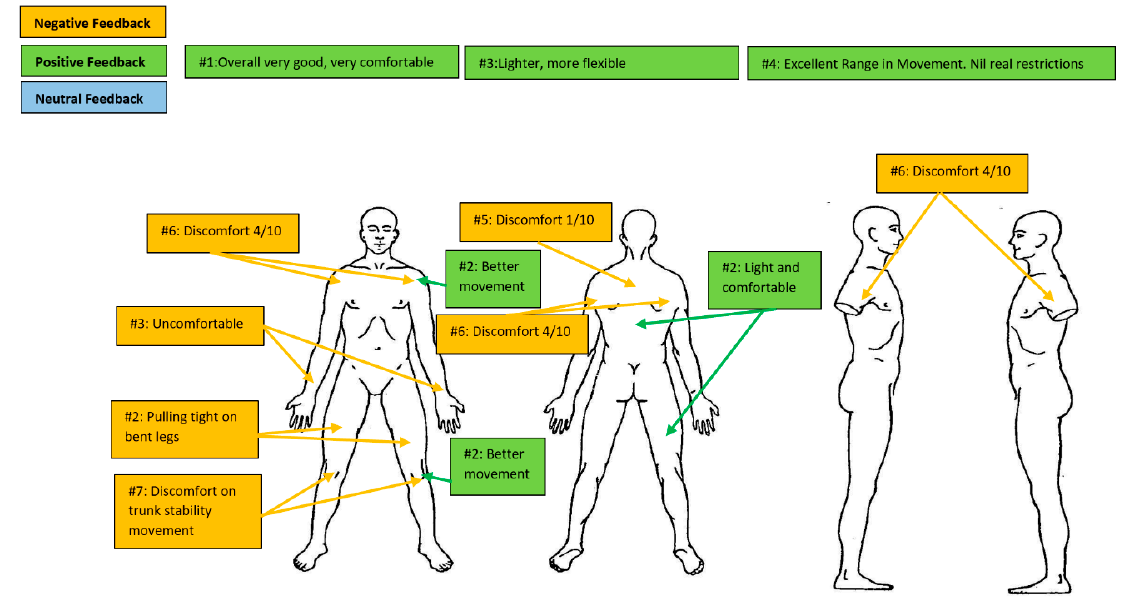
Figure 14. Subjective feedback (n = 8) on Variant 3 (#signifies participant number; scores out of 10 signify discomfort level).